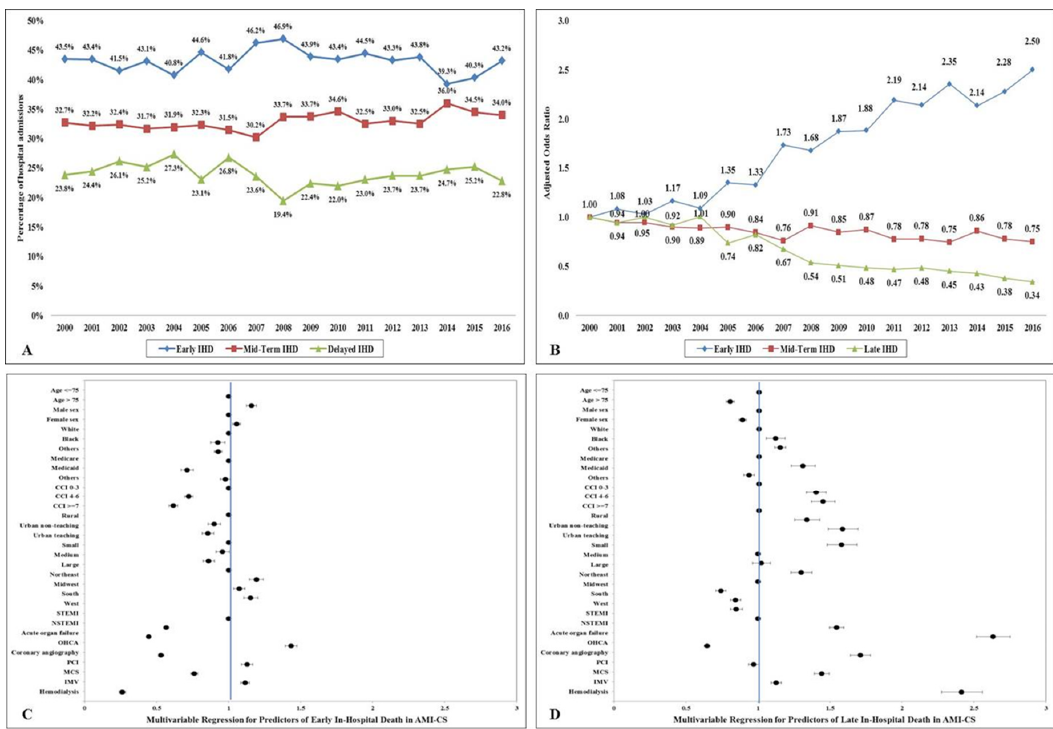
Figure 1. Epidemiology and predictors of in-hospital death in AMI-CS. ( A ) 17-year unadjusted temporal trends of early, mid-term and late IHD in AMI-CS; all p < 0.001 for trend over time; ( B ): 17-year adjusted* temporal trends for early, mid-term and late IHD in AMI-CS (referent year 2000); all p < 0.001 for trend over time; ( C , D ) the adjusted odds ratios for early ( C ) and late ( D ) IHD in AMI-CS**. * Adjusted for age, sex, race, primary payer status, socio-economic stratum, hospital characteristics,